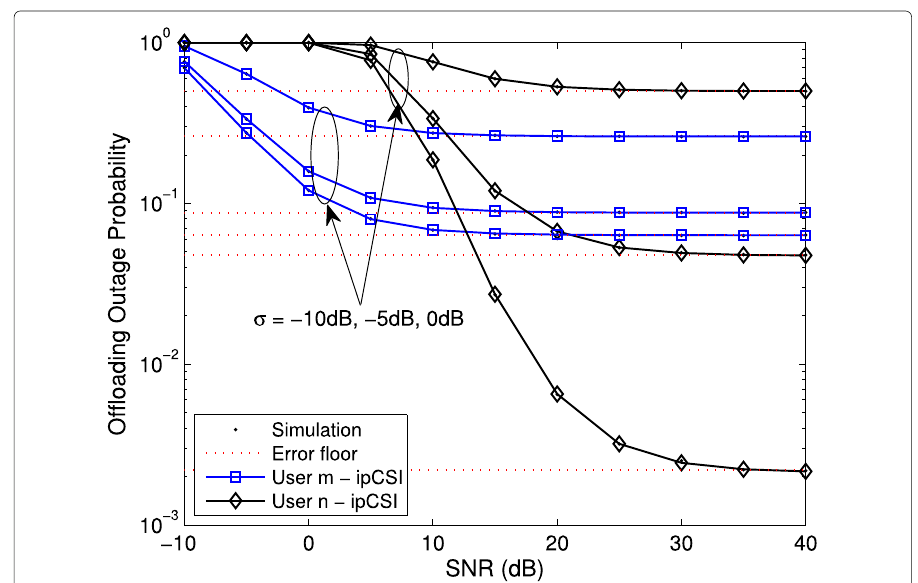
Fig. 4 Offloading outage probability versus SNR with various values of channel estimation errors